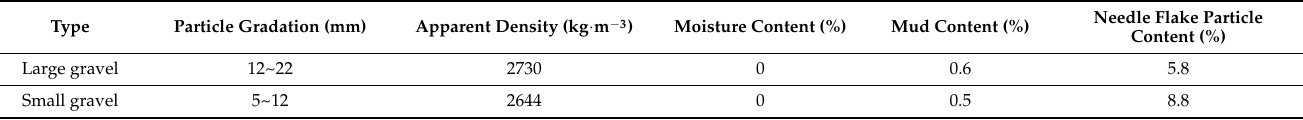
Table 3. Main technical indexes of limestone gravel.